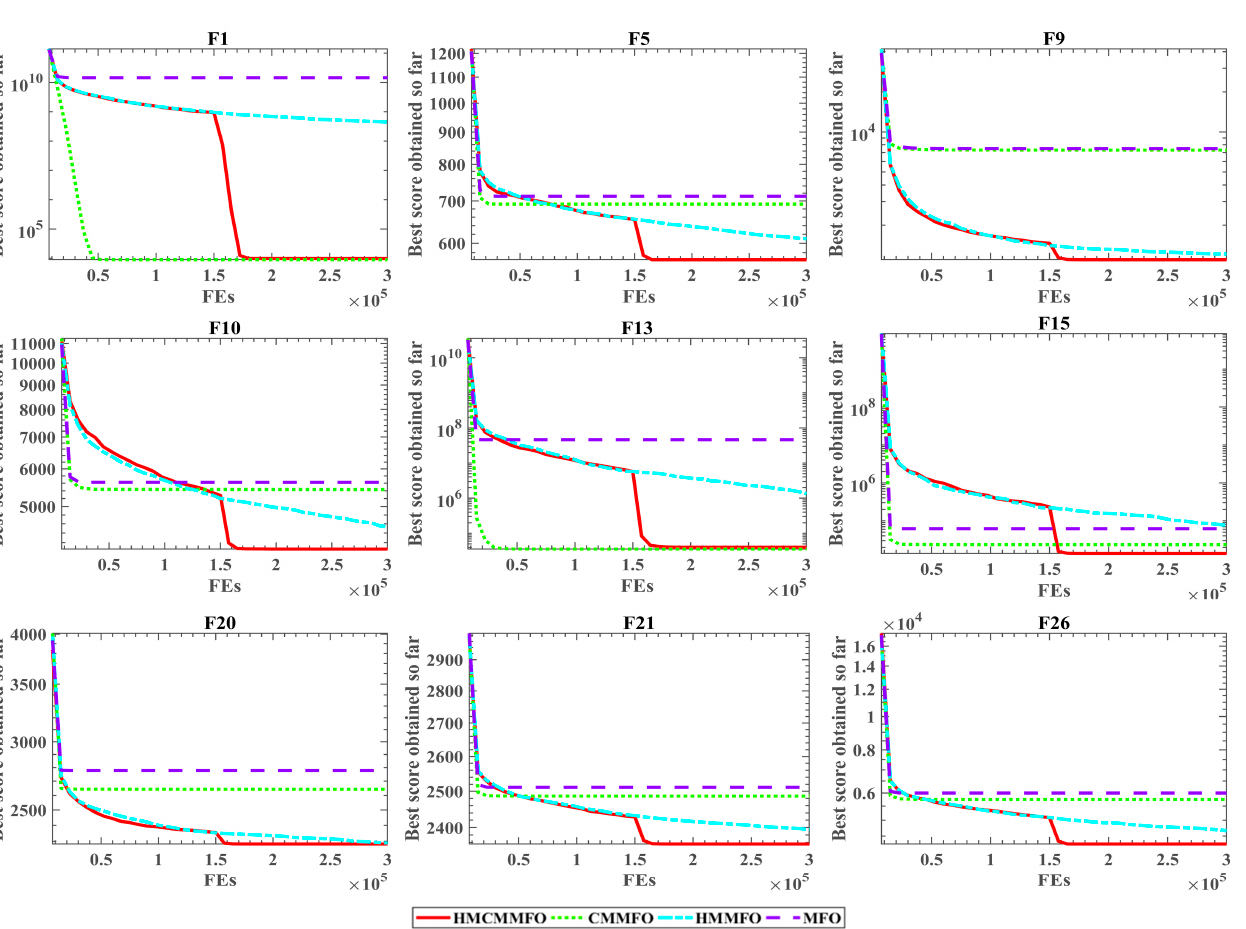
Figure 2. MFO convergence curves with different strategies.